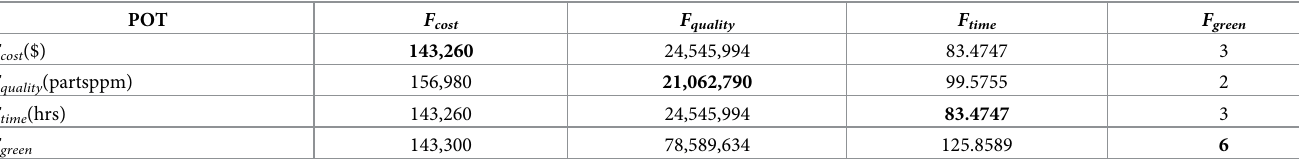
Table 12. Pay-off table of objective functions. POT F cost